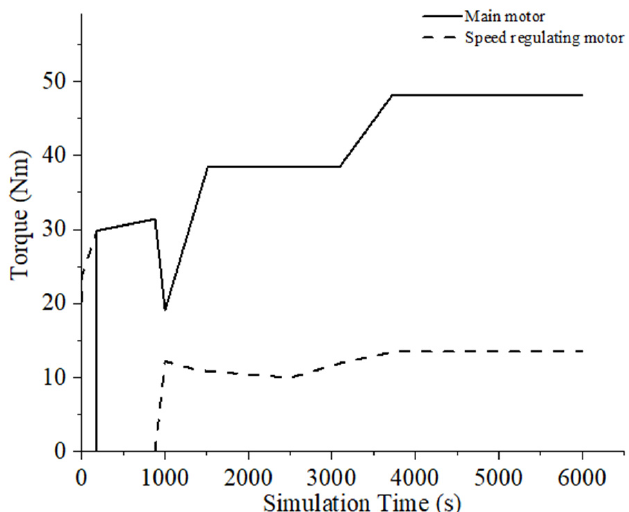
Figure 14. Simulation results of torque distribution algorithm.